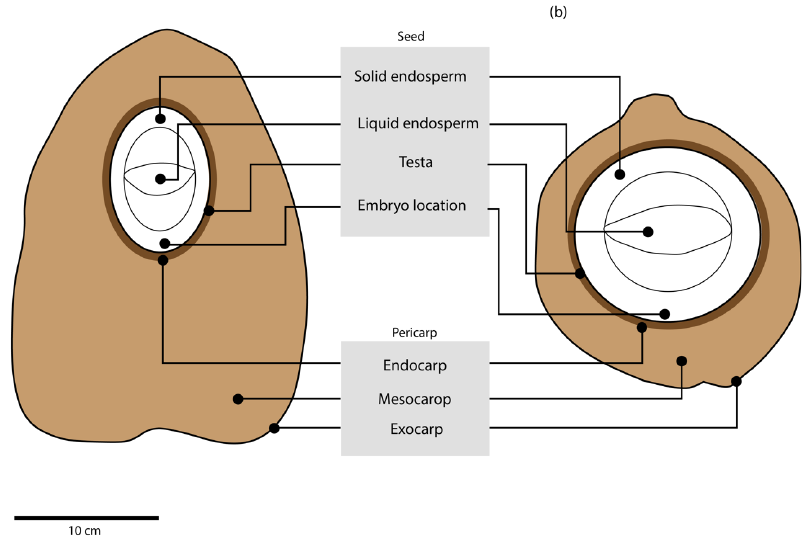
Figure 3. Differences in morphology of ( a ) wild and ( b ) domesticated coconut fruit. Domesticated varieties show a smaller pericarp region, having significantly less mesocarp as compared to wild types. They also have a rounder shape which allows a higher volume of water to be held inside the seed.